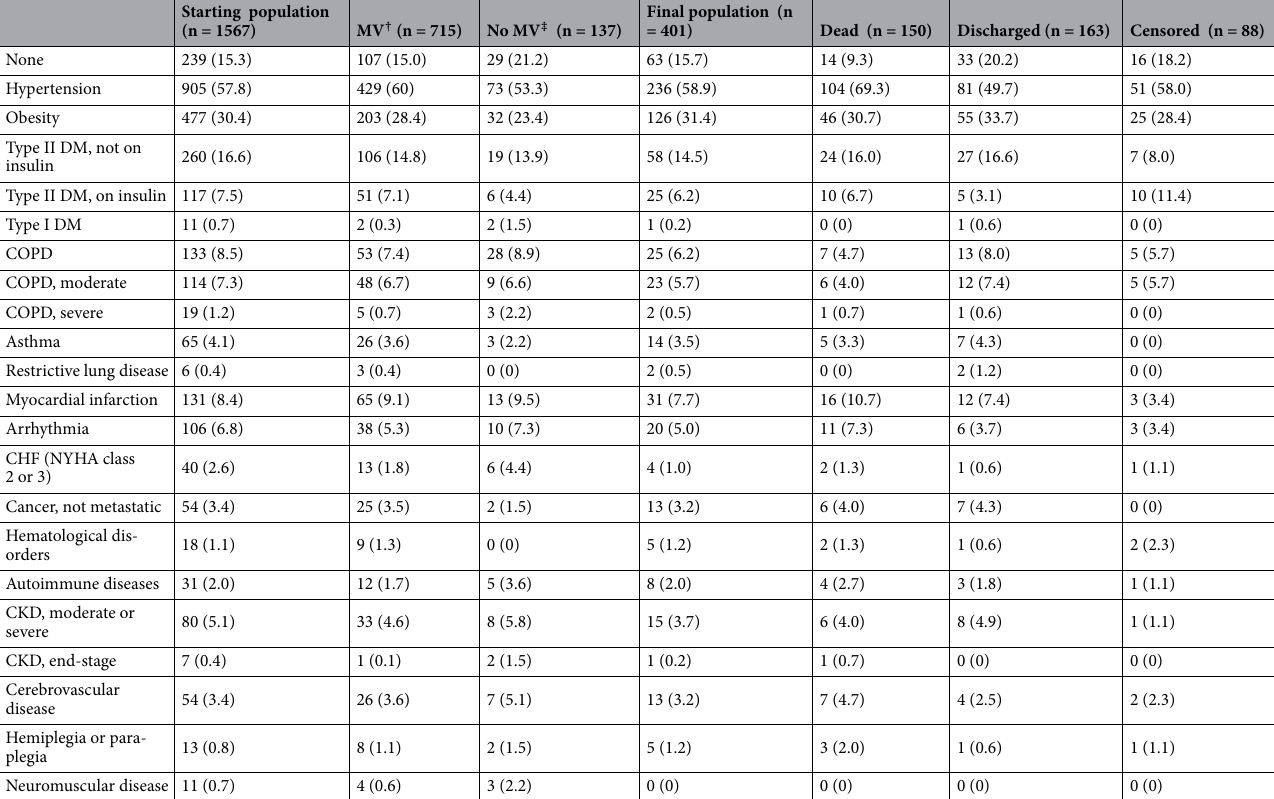
† MV indicates patients